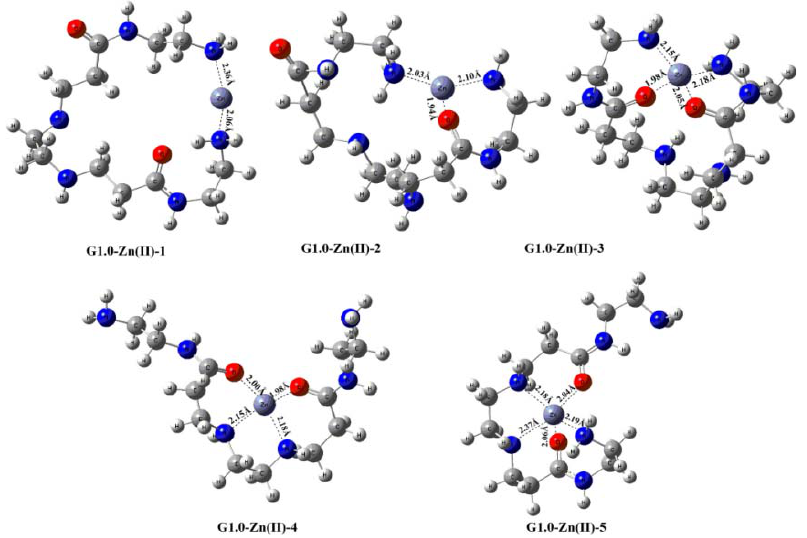
Figure 9. Optimized coordination structures of 1.0G PAMAM with Zn(II). Reprinted with permis- sion from Ref. [90]. 2020, Elsevier.